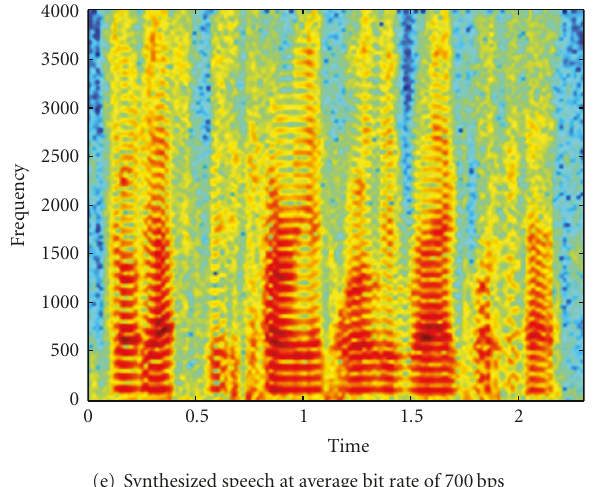
Figure 9: Spectrograms of synthesized speech signals using the proposed coder at di ff erent rates. The utterance is “Don’t ask me to carry an oily rag like that” from TIMIT, uttered by a male speaker. The vertical axis ranges from 0 to 4kHz and the horizontal axis is from 0 to 2.5